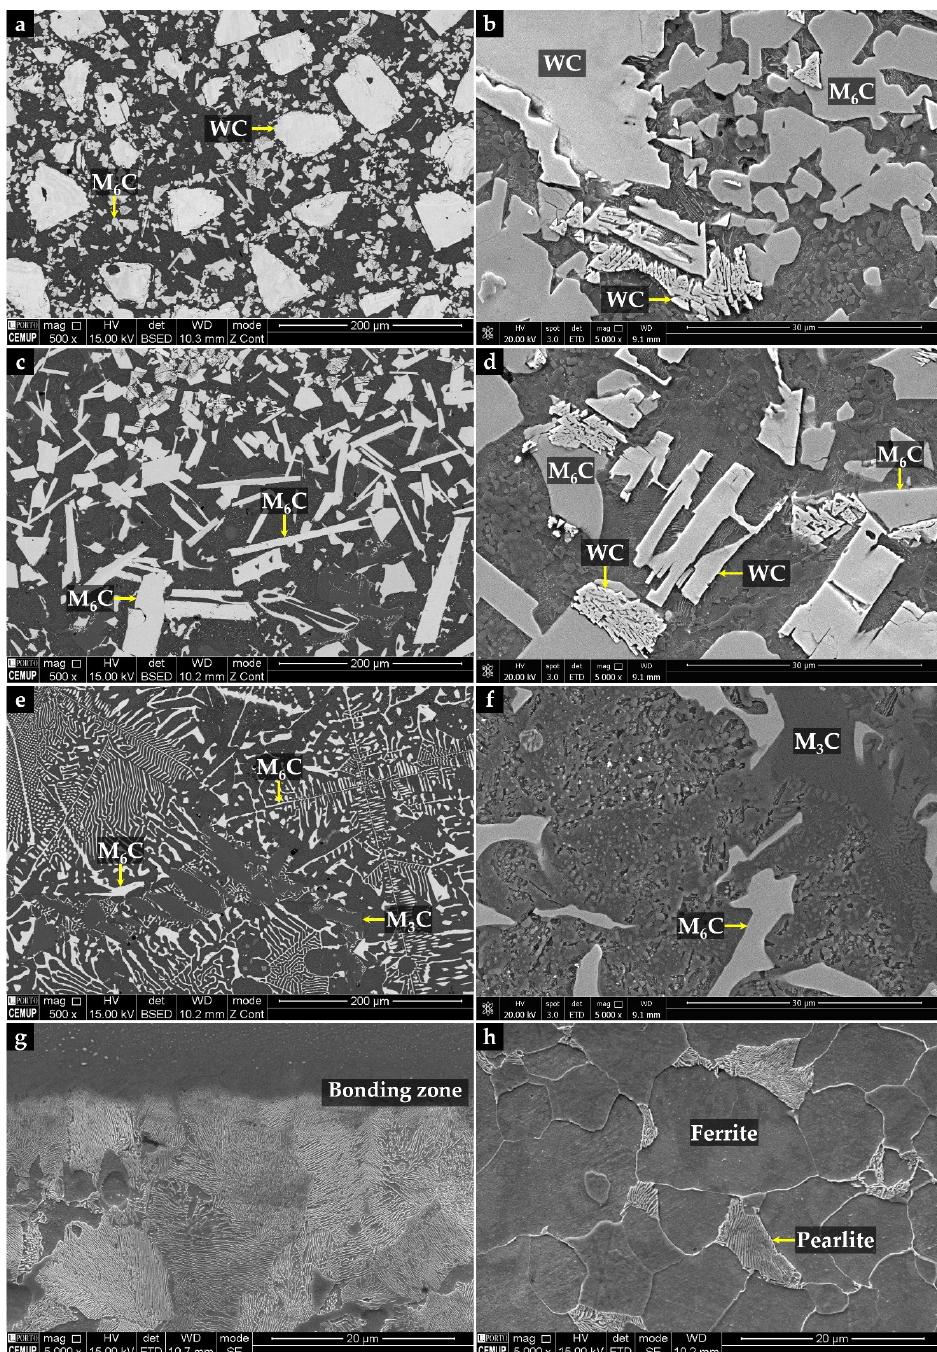
Figure 4. SEM images of the microstructure of the WC–MMC: CZ1 with a high content of original WC particles ( a ); (Fe,W) 6 C precipitation next to the WC particles ( b ); CZ2 evidencing a high number of (Fe,W) 6 C carbides with plate shape ( c ) and growth of (Fe,W) 6 C from the WC particles partially dissolved ( d ); CZ3 exhibiting essentially dendritic eutectic carbides of (Fe,W) 6 C and some massive carbides of (Fe,W) 3 C ( e ), and the same at higher magnification ( f ); bonding interface, showing the pearlite lamellar structure ( g ), and the base metal with a ferritic microstructure with a few pearlite colonies ( h